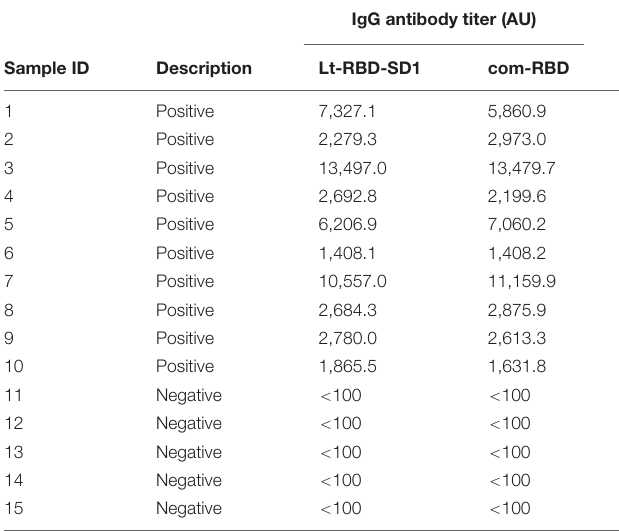
TABLE 3 | Antibody titers of 10 COVID-19–positive and five pre-pandemic (negative) human sera determined using Lt-RBD antigen produced in L. tarentolae and com-RBD antigen produced in HEK